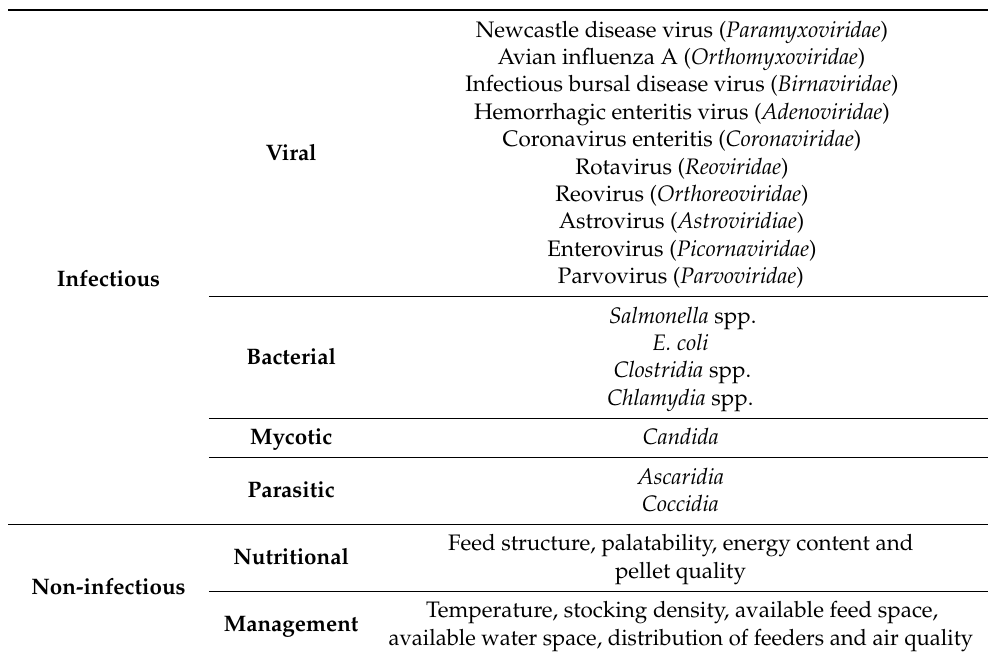
Table 1. Possible causes of enteric disorders in